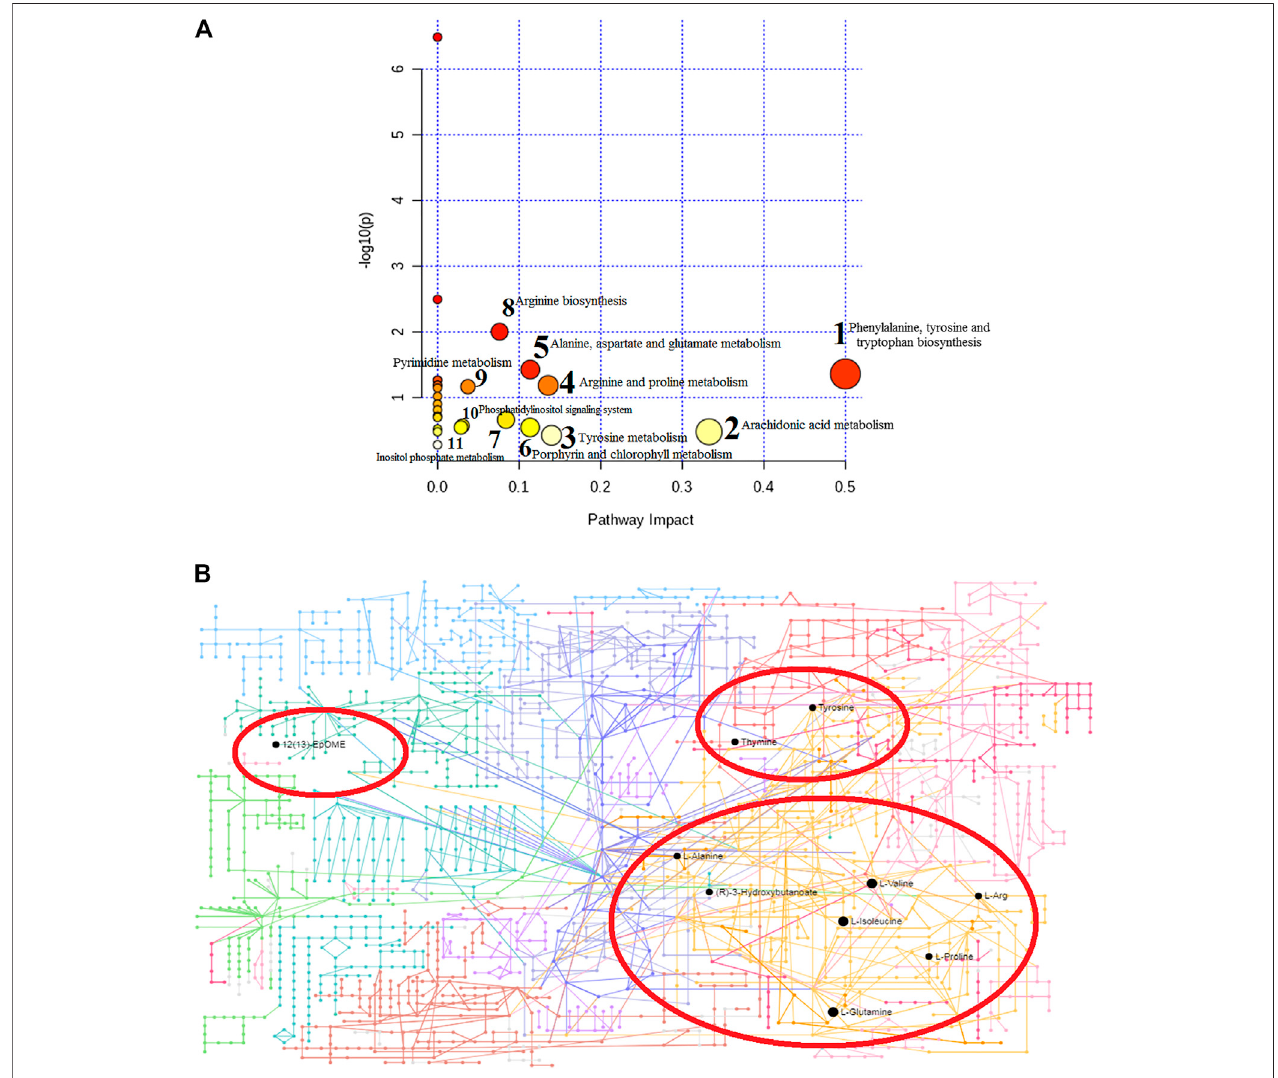
FIGURE 6 | Metabolic pathway analysis of identi fi ed 18 differential metabolites after Andro treatment, and impact value more than zero of pathways name (A) ; KEGG global metabolic network potential metabolites in model mouse after Andro administration (B) .